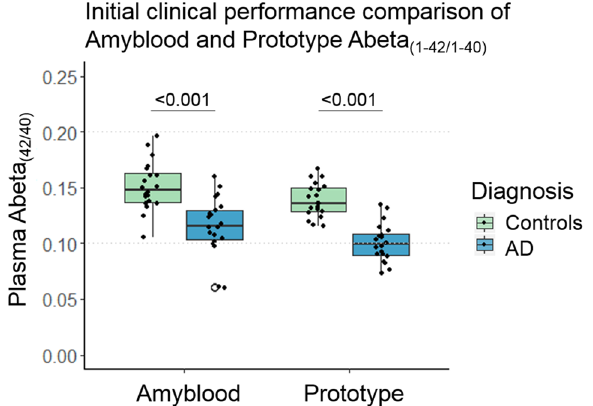
Figure 1. Abeta 1-42/1–40 ratio measured in AD and control samples with the Amyblood and Prototype assays. Comparison of the prototype and Amyblood assays was based on measuring a feasibility sample set of 40 samples, 20 CSF Abeta 1-42 positive AD cases and 20 CSF Abeta 1-42 negative controls, measured in duplicate in both assays. The average Abeta 1-42/1–40 ratio measured with the Amyblood assays were 0.151 ± 0.022 for controls and 0.116 ± 0.026 for AD, the average Abeta 1-42/40 ratio measured with the prototype was 0.139 ± 0.015 for controls and 0.100 ± 0.017 for